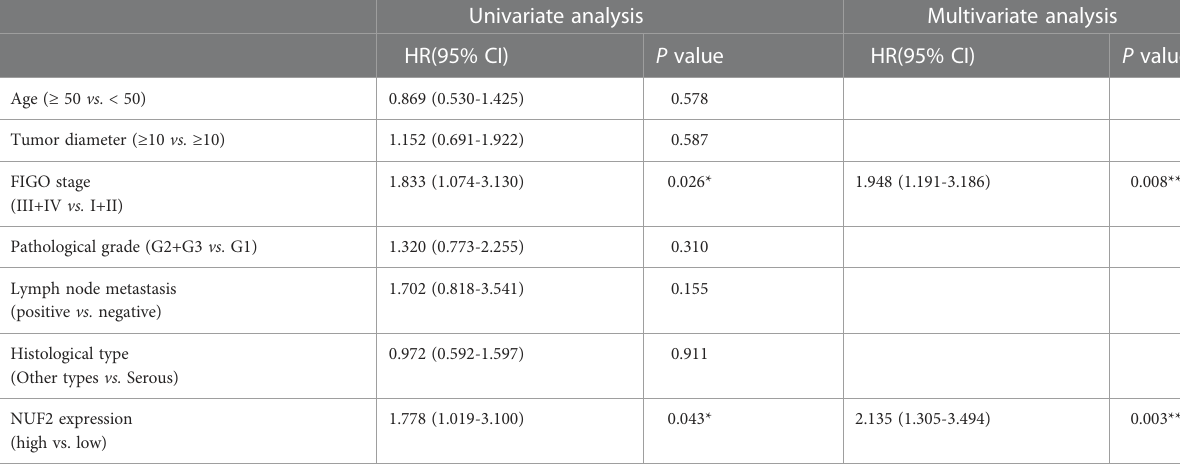
TABLE 2 Cox proportional hazard models for prognostic factors.